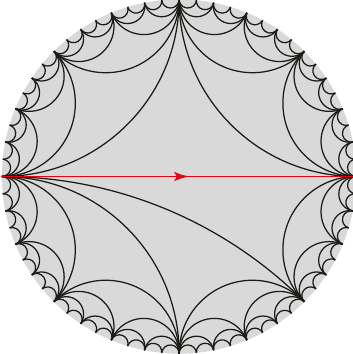
Figure 8 . The tessellation we obtain after (cid:13)ipping the geodesic connecting the boundary points 3 = 4 and 1 in the standard dyadic